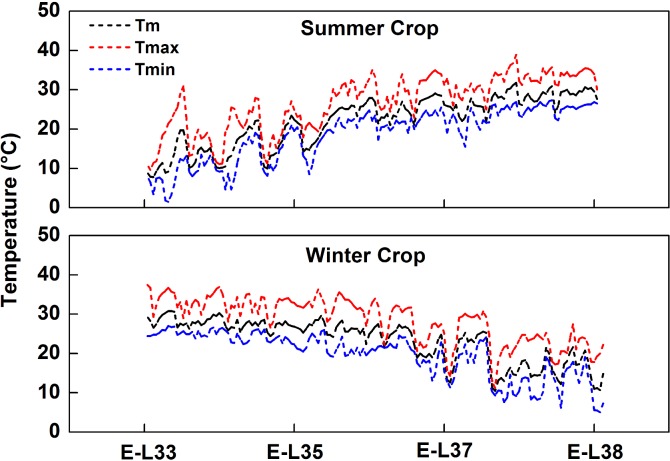
Meteorological data for both crops in 2016.Tm is the average daily temperature from February to June for the summer crop and from August to December for the winter crop. Tmax is the average daily maximum temperature from February to June for the summer crop and from August to December for the winter crop, and Tmin is the average daily minimum temperature from February to June for the summer crop and from August to December for the winter crop.